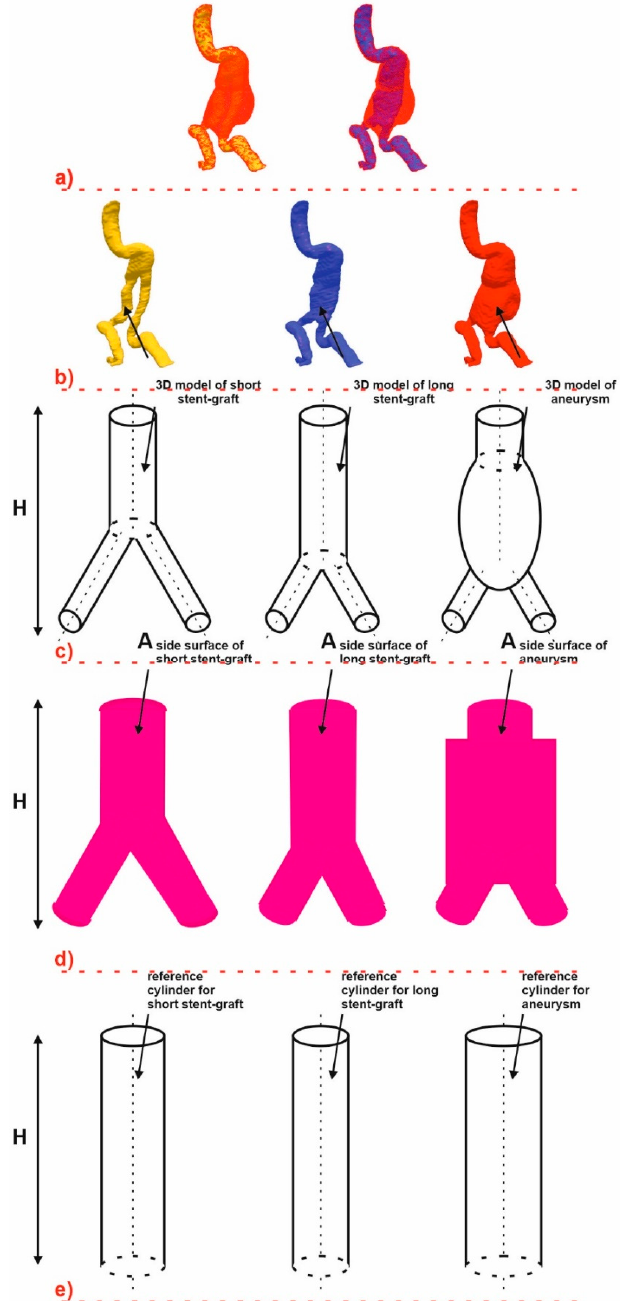
Figure 2. Diagram of shape factor calculation. ( a )—reference 3D geometries of abdominal aortic aneurysm (AAA) with long and short stent-graft; ( b )—reference 3D geometries of long and short stent-graft and AAA; ( c )—a schema of long and short stent-graft and AAA; ( d )—a schema of side surface of long and short stent-graft and AAA; ( e )—a schema or reference cylinders of long and short stent-graft and AAA.